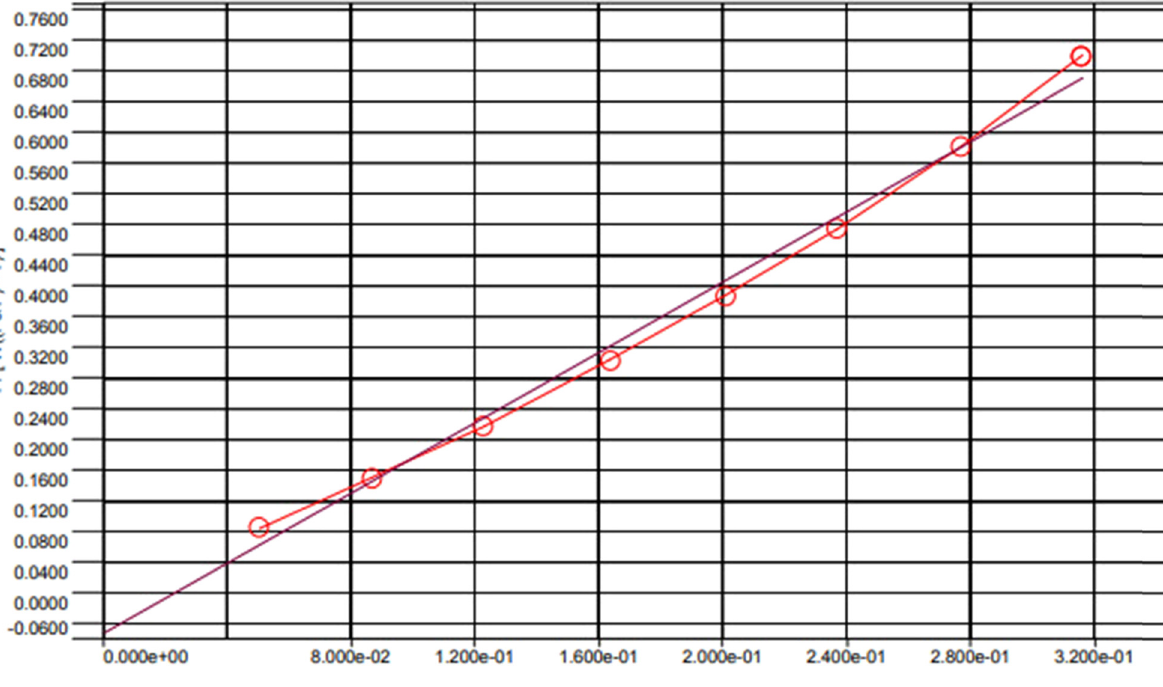
Figure A4: Nitrogen adsorption – desorption isotherm of CuCo - ZIFs.